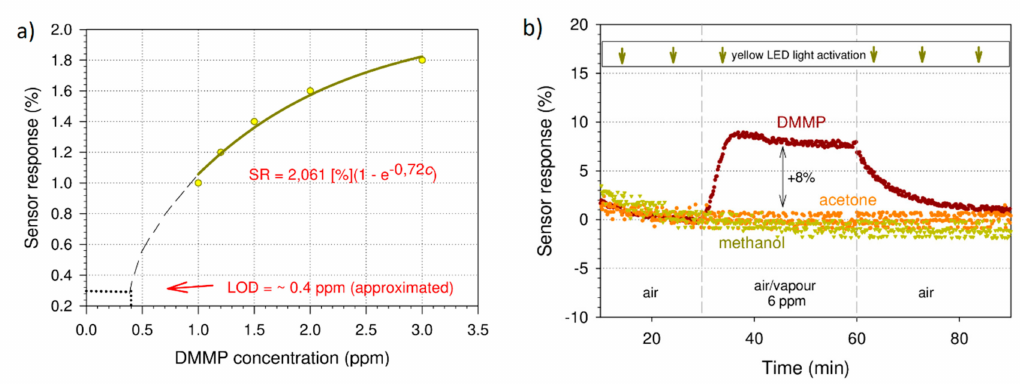
Figure 5. ( a ) The dependence of the sensor response on the DMMP concentration for the RR-P3HT layer activated by the yellow light; ( b ) the sensor response of RR-P3HT film exposed to the yellow LED light and 6 ppm of methanol (0% change), acetone (0% change) and DMMP (increase +